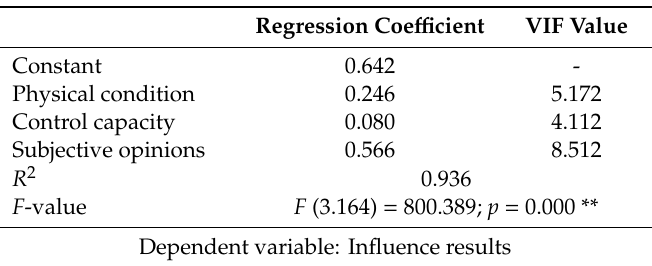
Table 6. Results of regression analysis.